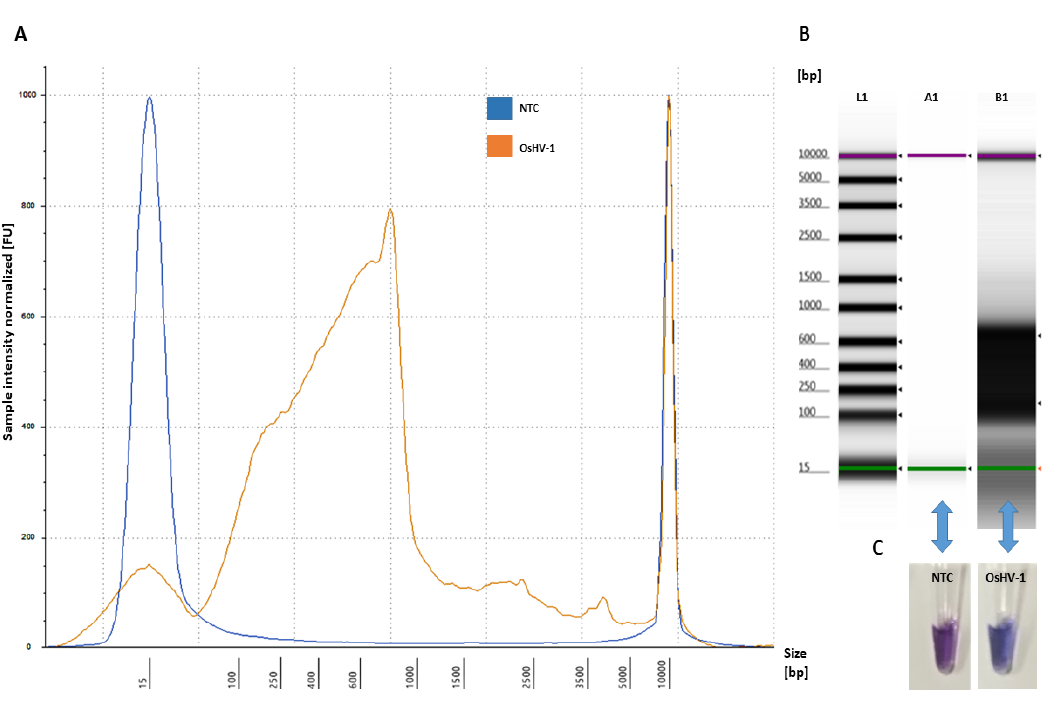
Figure 3. Amplification of OsHV-1 by LAMP assay: ( A ) electropherogram profile comparison of NTC (blue) and positive sample (OsHV-1 DNA-plasmid) (orange) analysed using Tape Station Analysis Software A.02.02 (Agilent Technologies, Cheshire, UK) with a progressive increase of the amplified LAMP product showing a size shift of 90–1000 bp; ( B ) gel image profile comparison: (L1)—ladder 15–5000 bp, (A1)—NTC and (B1)—positive samples showing a single high molecular band smear-like pattern (90 bp–1000 bp) of the amplified LAMP product visualized using Tape Station Analysis Software A.02.02 (Agilent Technologies, Cheshire, UK); and ( C ) NTC (violet) and positive samples (OsHV-1 DNA-plasmid) (blue) visualized using HNB.